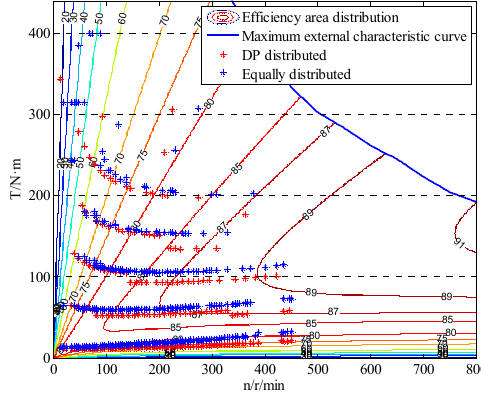
Figure 13. Torque distribution ratio map optimized by dynamic planning algorithm for HUPDC.